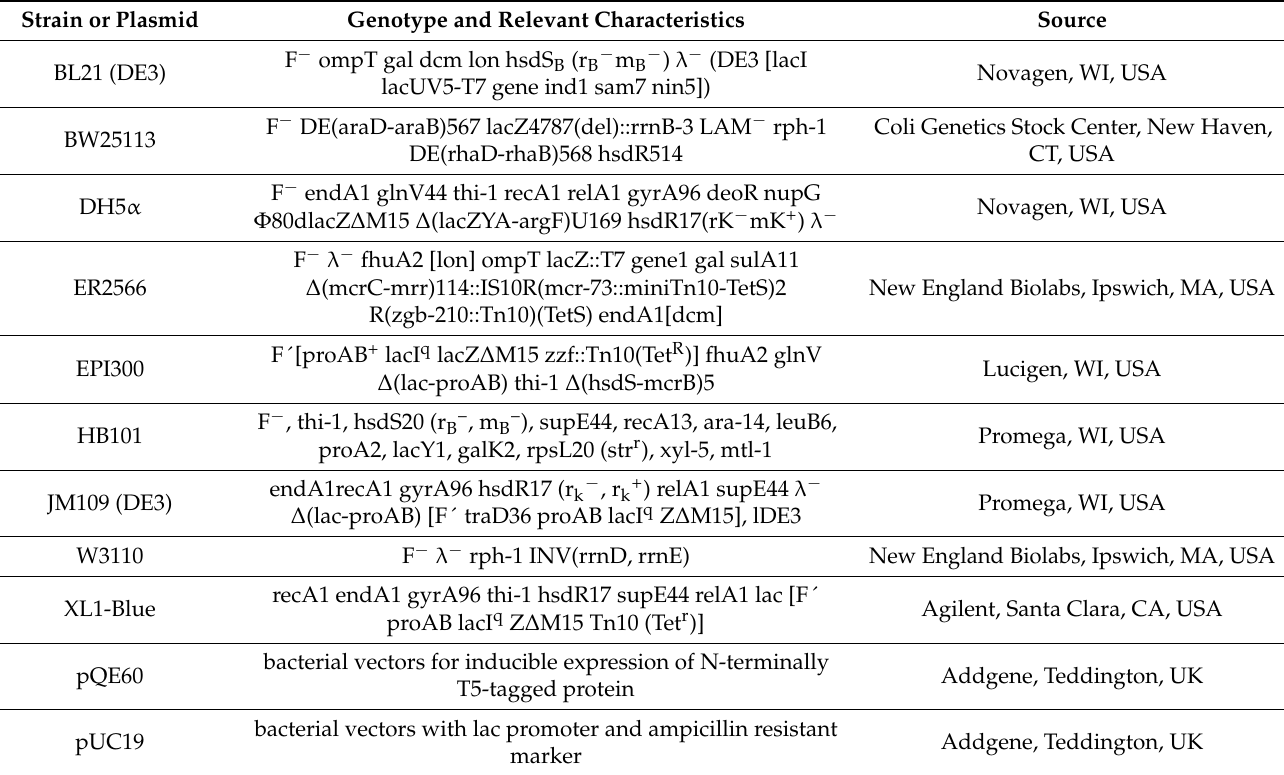
Table 7. The strains and plasmid used in this